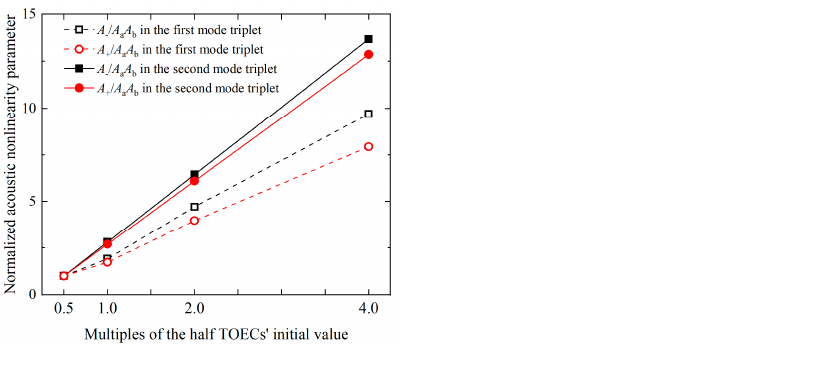
Figure 16. Variation of normalized acoustic nonlinearity parameters versus multiples of the half TOECs’ initial value.